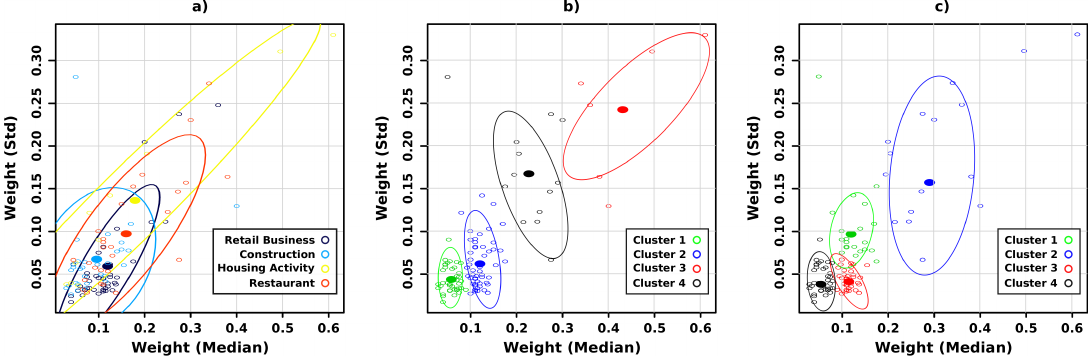
Figure 13. ( a ) Dispersion plot: weight median vs weight standard deviation. ( b ) A clustering k-mean algorithm was applied for k = 4. ( c ) A clustering PAM algorithm was applied for k = 4.